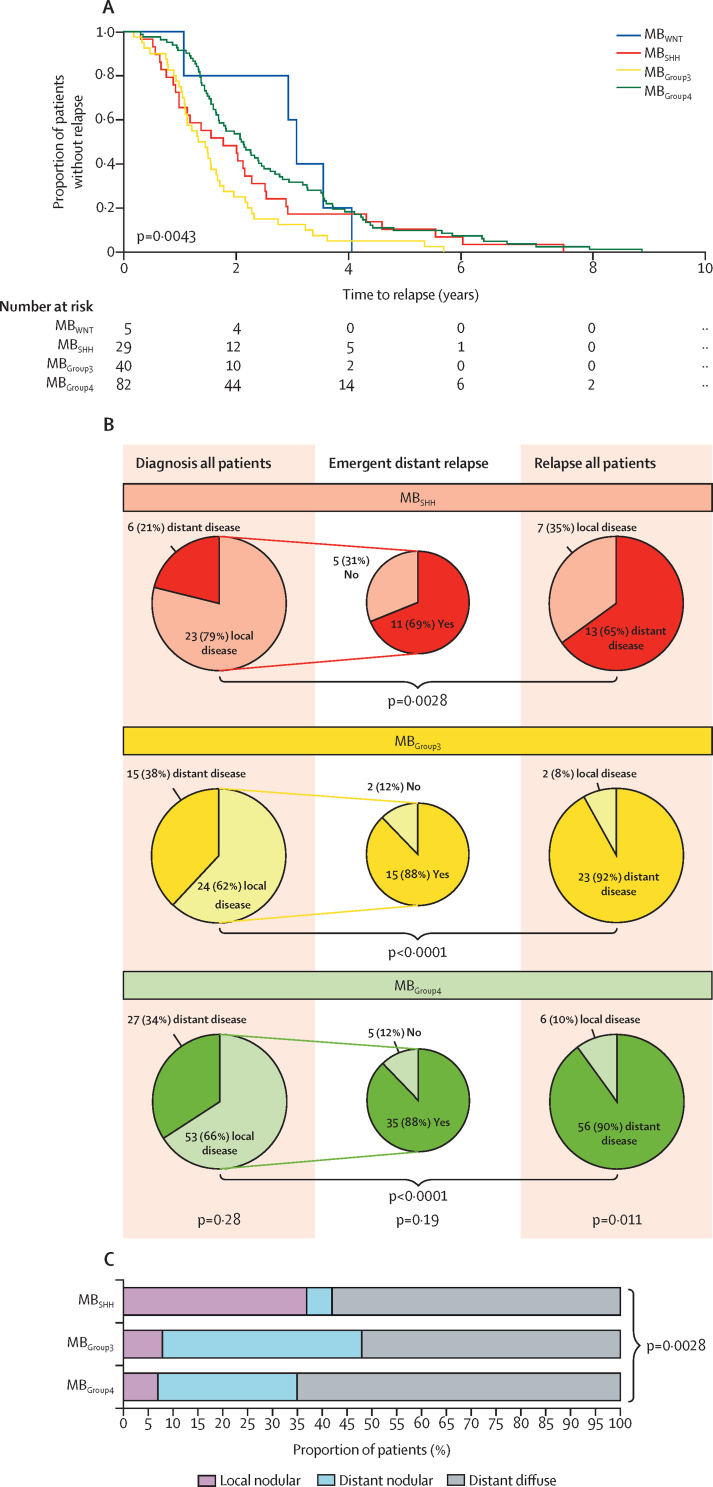
Time to relapse and pattern of relapse according to molecular subgroup in the irradiated group(A) Time to relapse in the four consensus molecular subgroups in patients who received upfront CSI (irradiated group). (B) Schematic representing the patients with distant disease at diagnosis, emergent distant disease at relapse, and distant disease at relapse according to molecular subgroup. (C) Different patterns of relapsed disease according to molecular subgroup and relapse pattern. MBSHH=19 patients, MBGroup3=25 patients, MBGroup4=58 patients. CSI=craniospinal irradiation. MB=medulloblastoma.